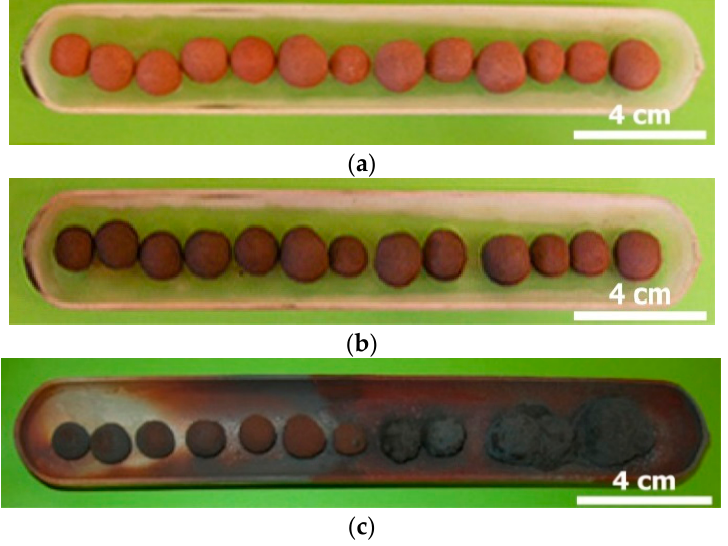
Figure 17. Visual images of (hematite–PVC–kaolinite) mixtures: ( a ) initial mixture; ( b ) treated at 300 °C; and ( c ) treated at 1050